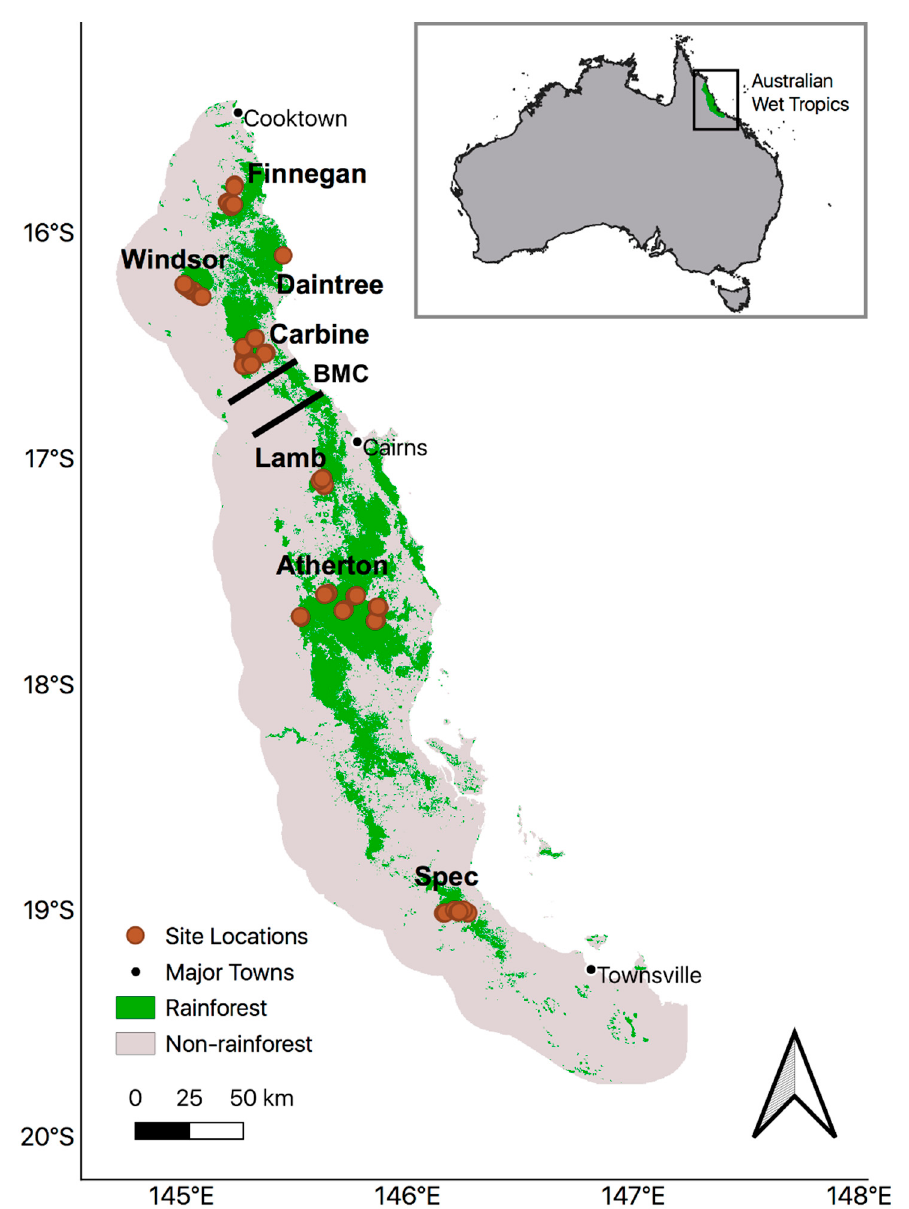
Figure 2. Map of the Australian Wet Tropics (AWT) showing survey site locations for each subregion (naming of subregions follows [13]). Rainforest distribution is shown in green. BMC is the Black Mountain Corridor and represents a well ‐ known biogeographic barrier for numerous taxa within the AWT.